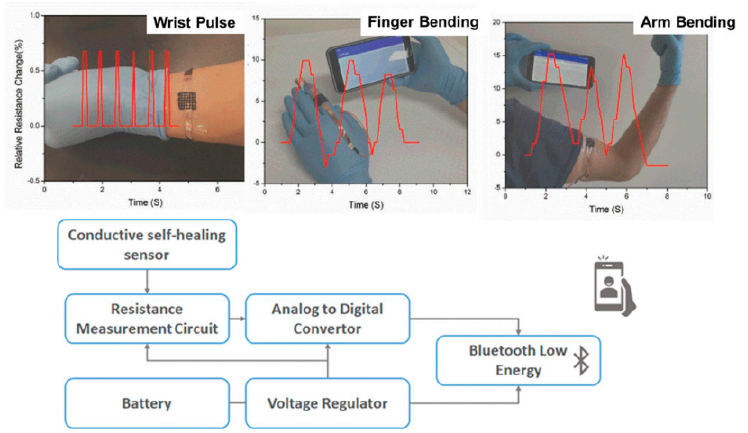
Figure 8. ( Top ): Examples of sensors used to measure wrist pulse, finger bending and arm bending. ( Bottom ): Block diagram of the wireless bodily motion detection system (this figure was adapted with permission from the authors in Reference